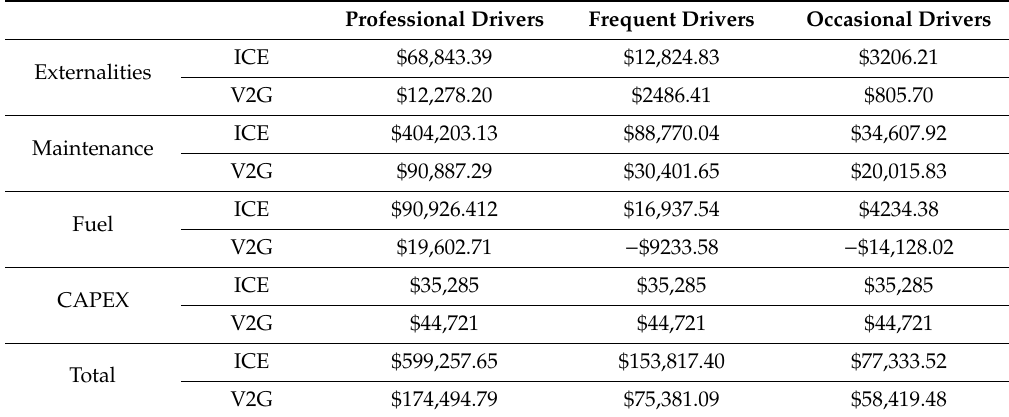
Table 4. Costs summary of ICE and V2G.